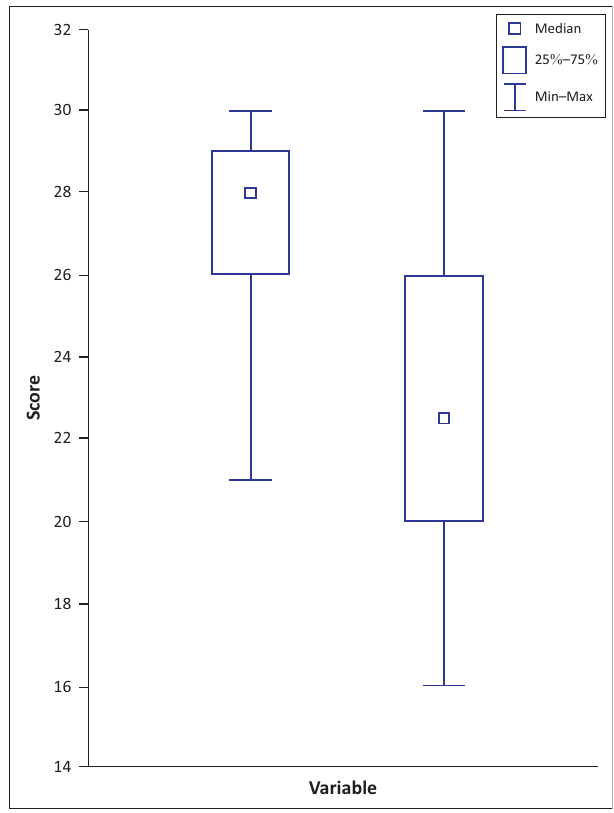
FIGURE 1: Comparing the Mini-Mental State Examination and Montreal Cognitive Assessment Test